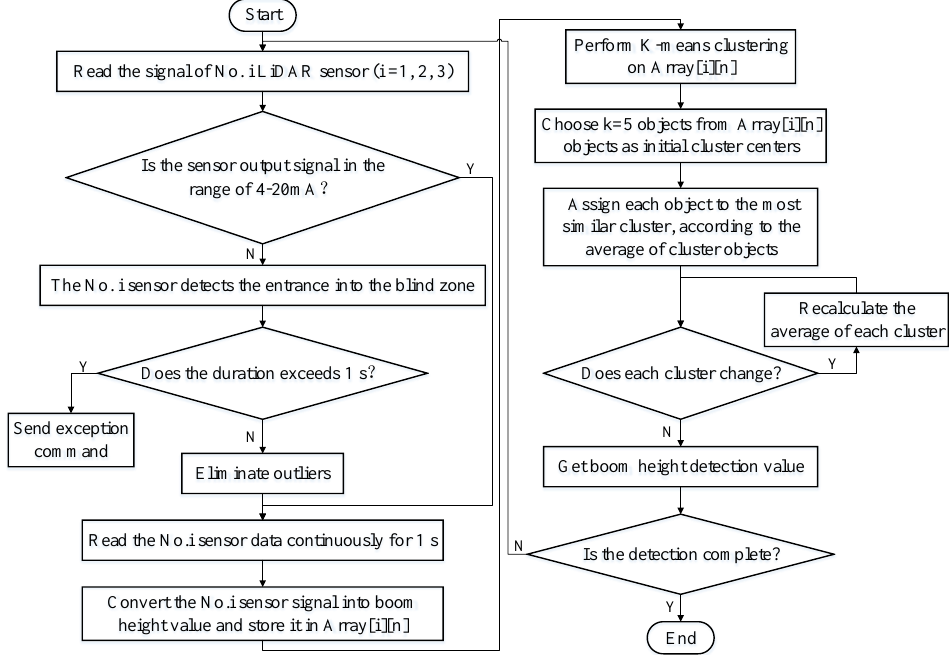
Figure 6. Flow chart of H b calculation based on the K-means clustering algorithm.